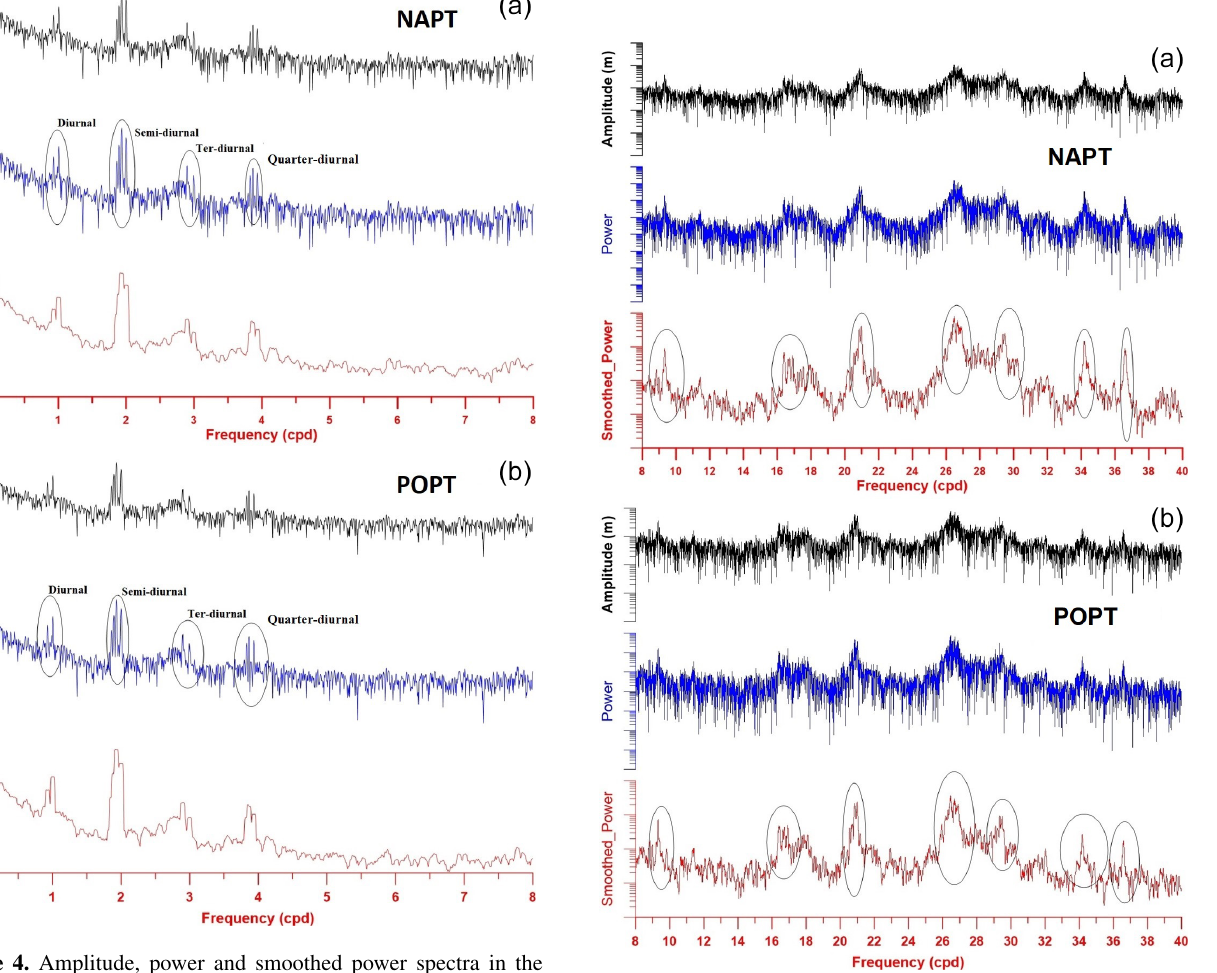
Figure 4. Amplitude, power and smoothed power spectra in the range 0–8 cpd. The black ellipses contain the frequency range of the four tidal species for NAPT (a) and POPT (b) tide gauge sta- tion; frequency is expressed in cycle per day (cpd).